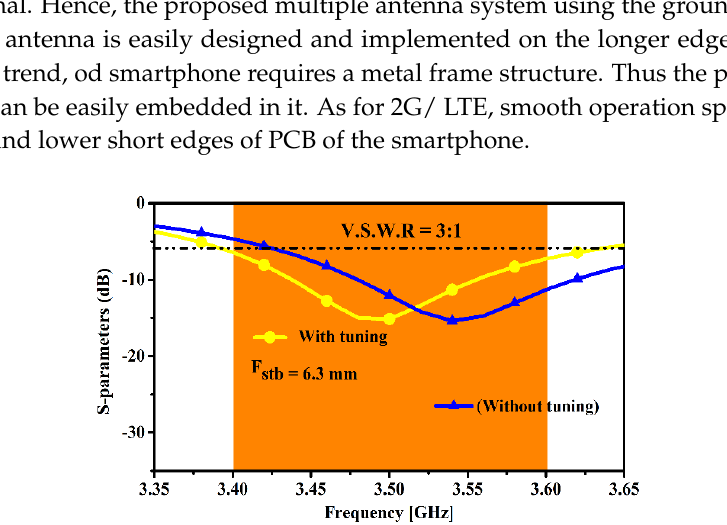
Figure 16. Comparison of simulated S 11 of Ant1 by tuning the F stb parameter. Table 3. Performance comparison with smartphone antenna. Abbreviation: Number of